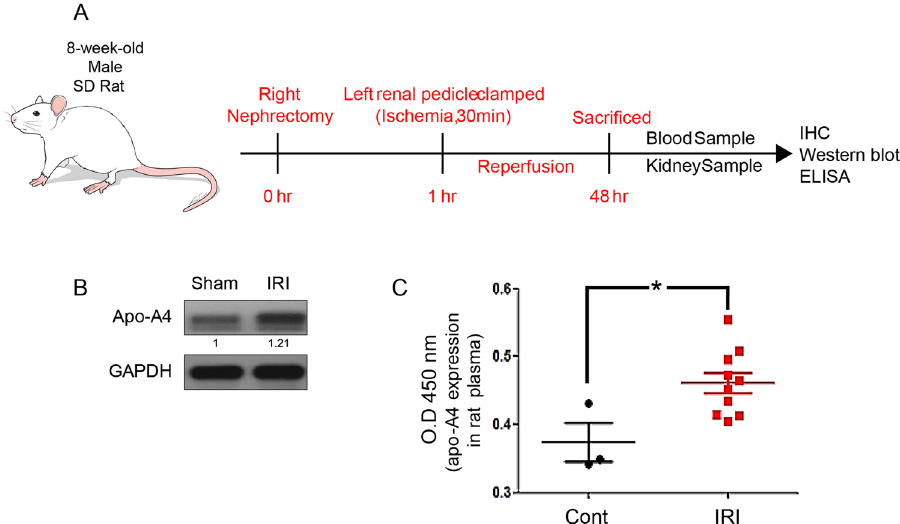
Figure 3. Inflammatory AKI induced by TNF- α increased apo-A4 expression in vivo . ( A ) Graphical presentation of in vivo experiment method with male SD rat. ( B ) Expression of apo-A4 protein detected by western blotting of kidney tissue from an ischemic reperfusion injury rat model. ( C ) Apo-A4 expression in rat plasma measured by ELISA. Results represent the mean ( ± SEM) of ten independent experiments (n = 10). The statistical signification was marked as * for p < 0.05 compared with the